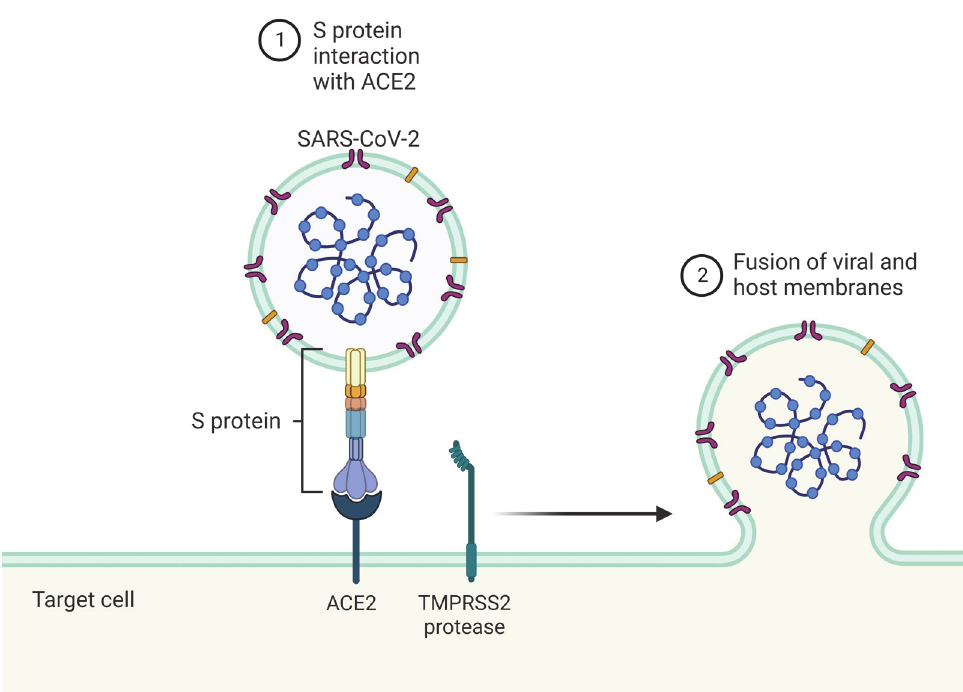
Figure 1. (1) SARS-CoV-2 uses its spike (S) protein to bind host angiotensin-converting enzyme 2 (ACE2). (2) Transmembrane serine protease 2 (TMPRSS2), a second host membrane protein, cleaves S protein to initiate the fusion of viral and host membrane. Thus, viral tropism of SARS-CoV-2 is highly determined by the presence of both ACE2 and TMPRSS2 on the host membrane.